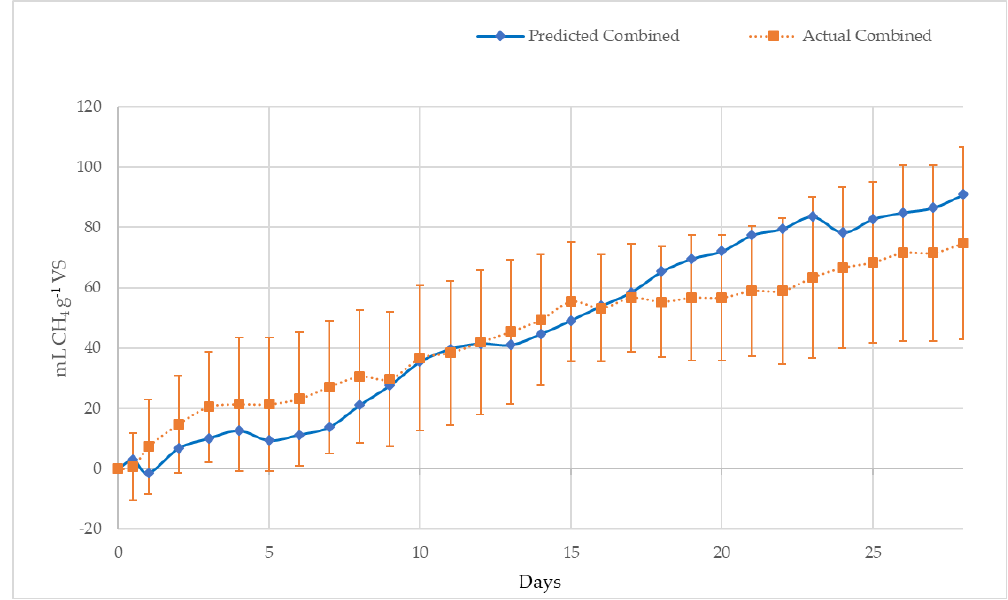
Figure 6. The plot of the predicted yield of methane for the combined S. natans VIII, S. natans I and S. fluitans (based on the previous experimental results for each species) and the actual methane yield.